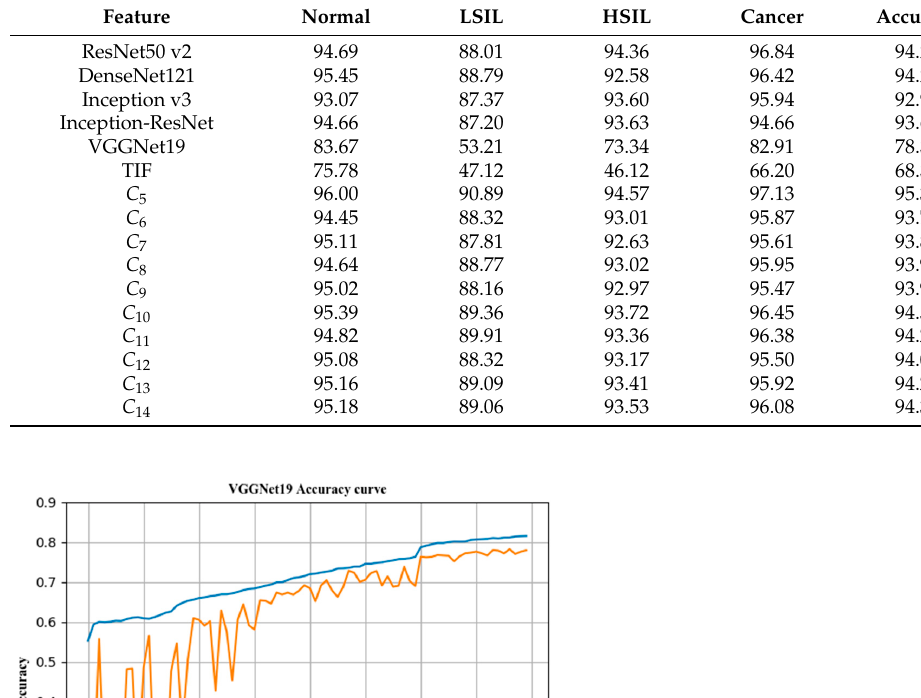
Table 5. Optimal test classification accuracy of pathological cervical tissue images (unit: %).